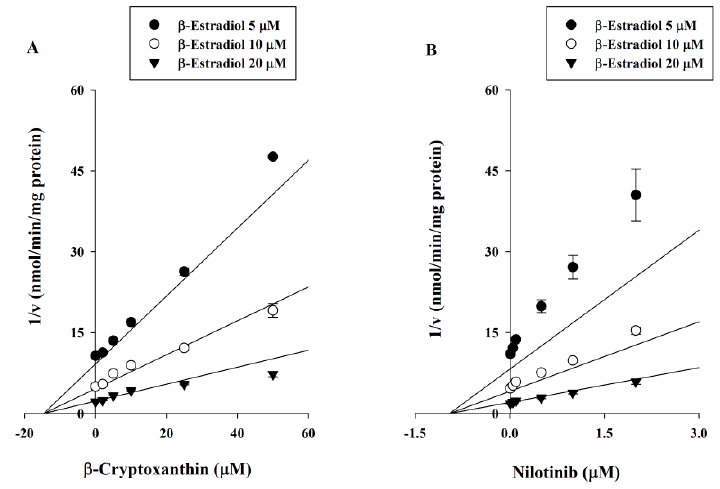
Figure 2. Dixon plots of the inhibitory effects of β -cryptoxanthin ( A ) and nilotinib ( B ) against UGT1A1-catalyzed β -estradiol-3- glucuronide in human liver microsomes. The concentrations of β -estradiol were determined 5 ( ● ), 10 ( ○ ), and 20 ( ▲ ) μ M, respectively. The v represents formation rate of β -estradiol-3-glucuronidation (nmol/min/mg protein). Data are the mean ± standard deviation of triplicate experiments. The solid lines of β -cryptoxanthin and nilotinib fit well with a competitive mode of inhibition.